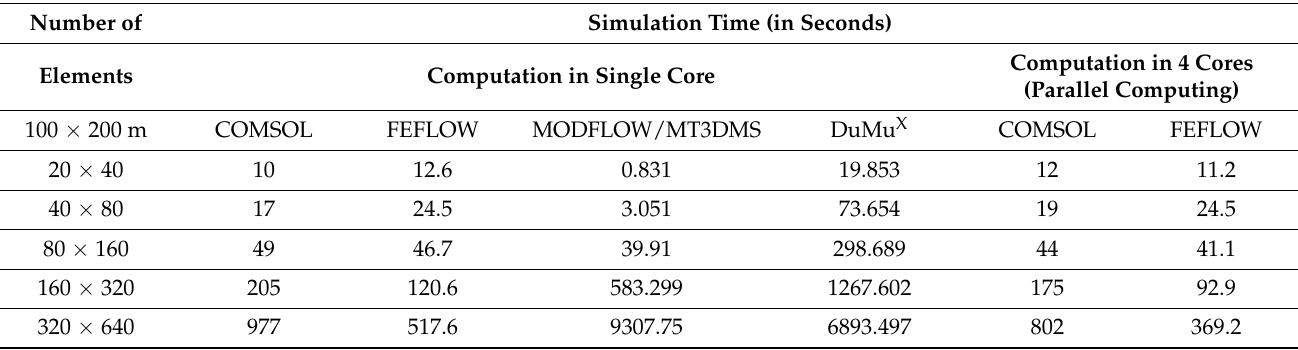
Table 1. Simulation times for Problem 2 (2D domain) with respect to different mesh refinements.